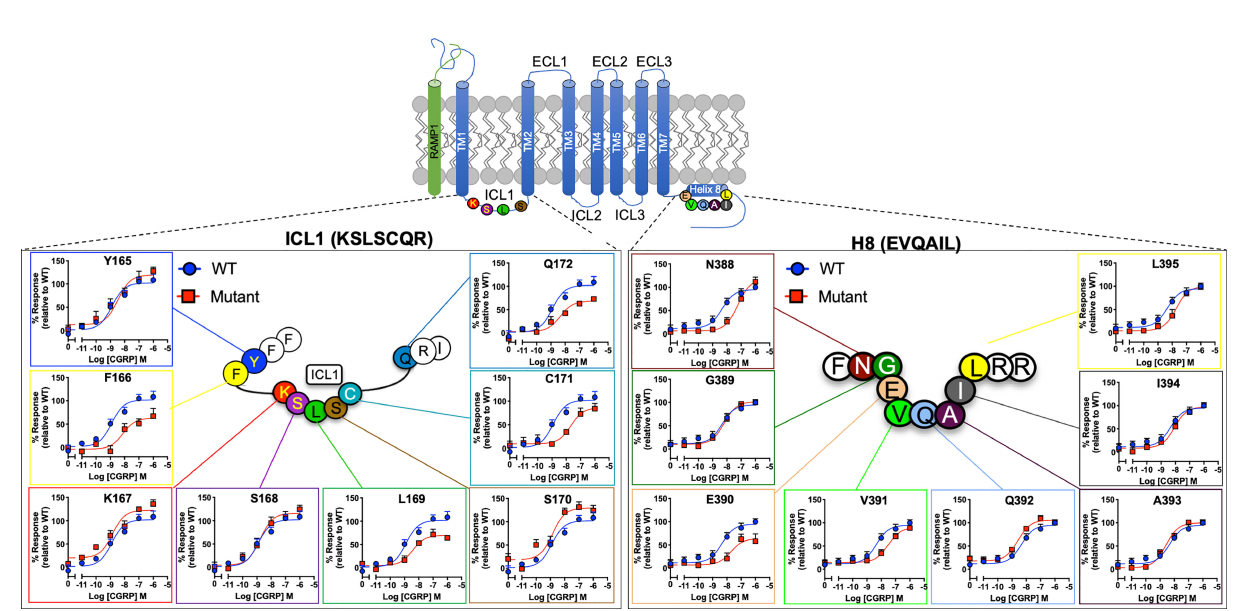
FIGURE 2 | Mutational analysis of residues in ICL1/H8 at the CGRP receptor. Residues in the ICL1 (left) and H8 (right) were mutated to Ala (except A393 where Leu was used) and the effects on cAMP production compared to wild type receptor. Mutant curves are show in red, wild type in blue. All data are mean ± SEM of n repeats where n=minimum of 3